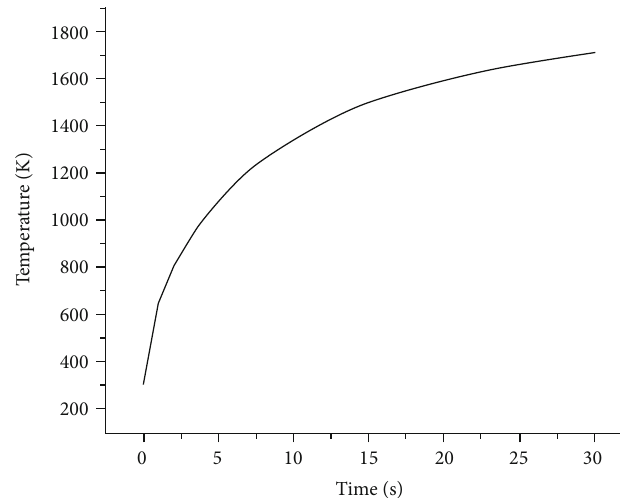
Figure 18: The temperature at the stagnation